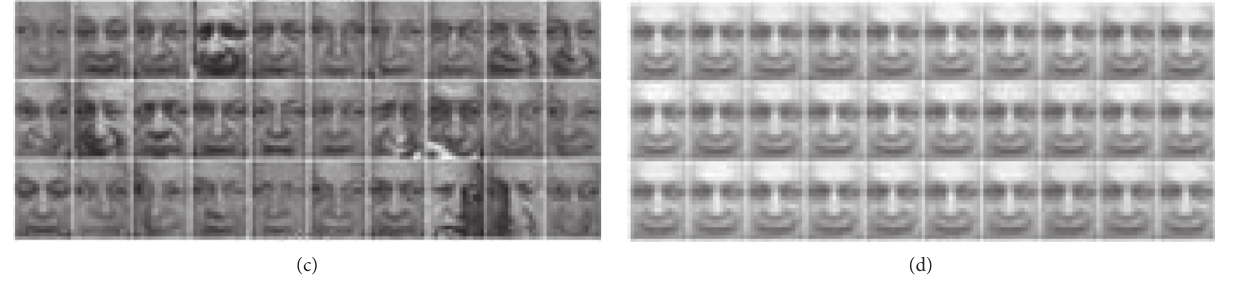
Figure 4: Some recovered natural face images. (a) Original, (b) NQLSD, (c) RASL, and (d) proposed method.